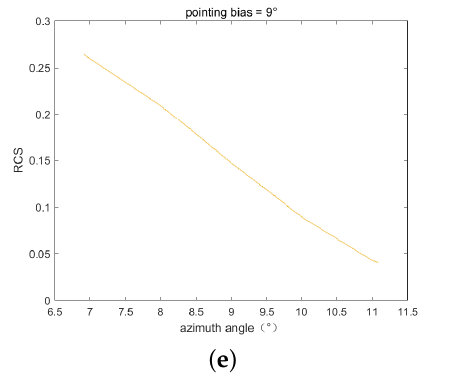
Figure 9. The normalized RCS pattern with different pointing deviations in the case of misalignment. ( a ) Pointing deviation = 5 ◦ ; ( b ) pointing deviation = 6 ◦ ; ( c ) pointing deviation = 7 ◦ ; ( d ) pointing deviation = 8 ◦ ; ( e ) pointing deviation = 9 ◦ .